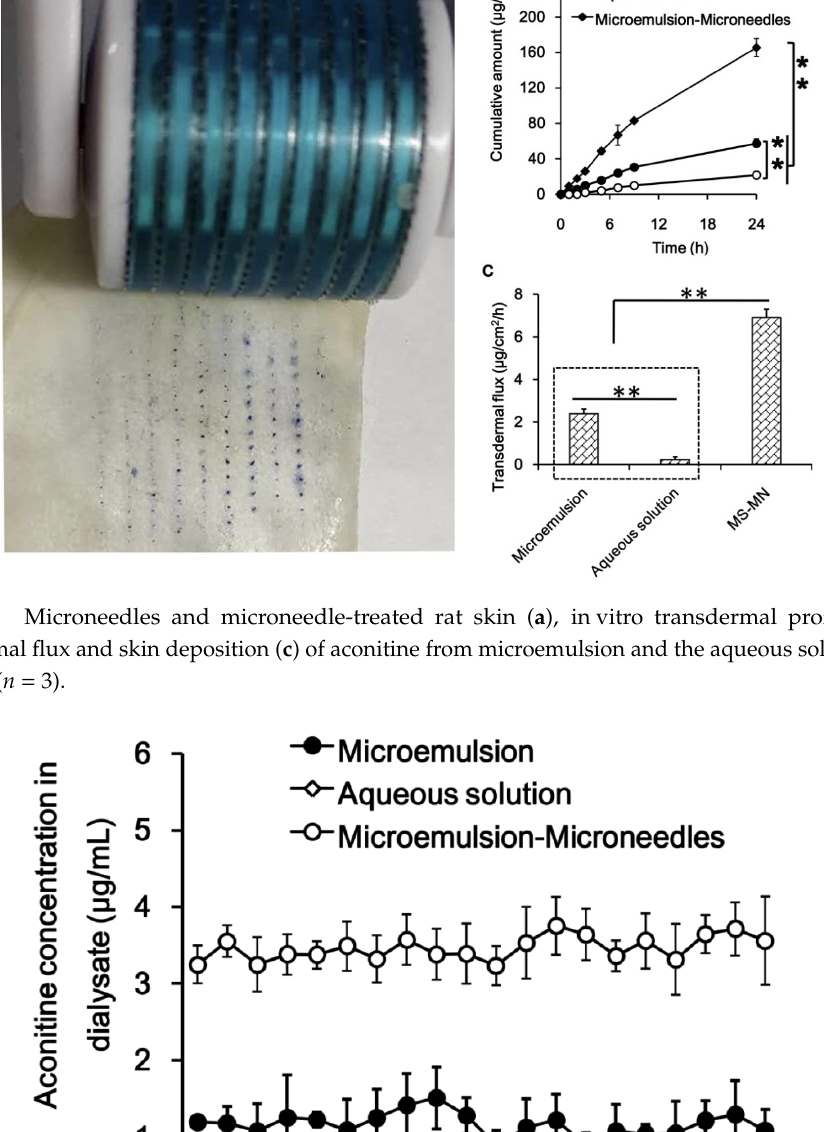
Figure 5. Micrographs of rat skin sections embedded in paraffin and stained with hematoxylin and eosin by using microdialysis sampling for 10 h after application of aconitine-loaded microemulsion.